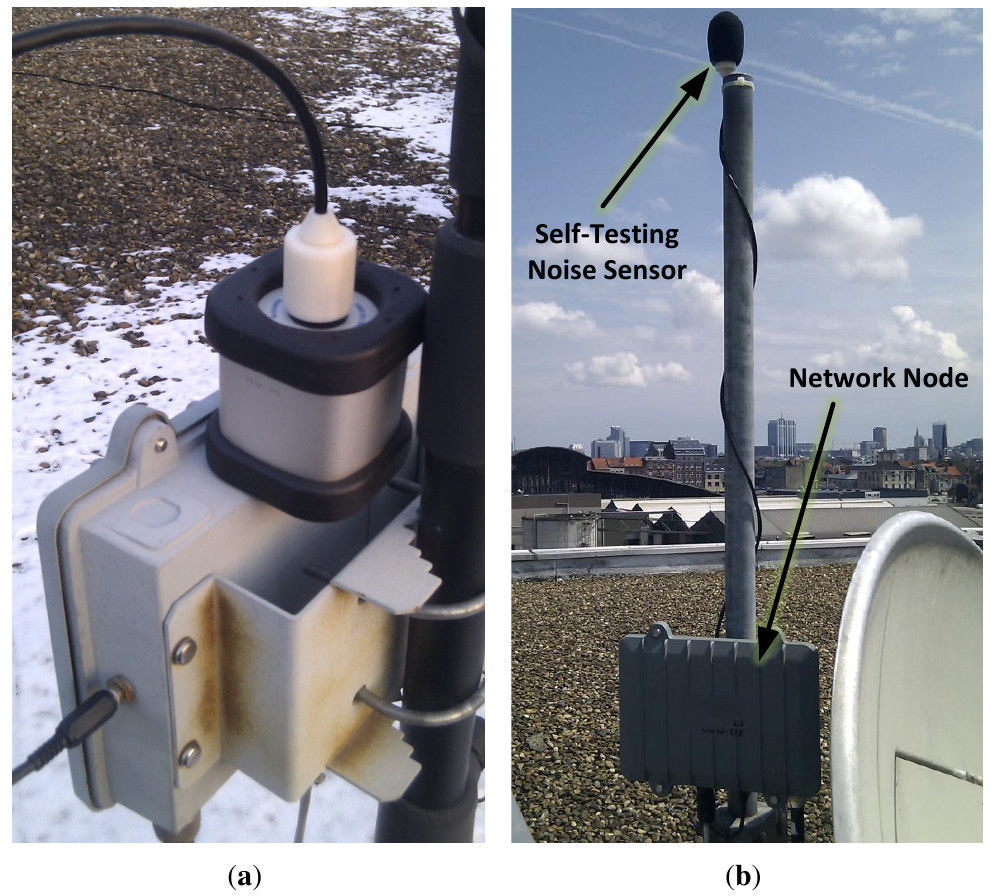
Figure 3. The self-testing noise measurement sensor has been tested outdoors for several months in temperatures ranging from − 13 to 38 ◦ C. ( a ) The casing design has a removable inch cylinder with the microphone capsule on top, this allows top cap that exposes the 1 2 easy in the field calibration; ( b ) Here, a measuring station (node + sensor) is recording the environmental noise of a busy market in Brussels, Belgium. The sensor prototype is seen here covered with a windscreen to protect it from the